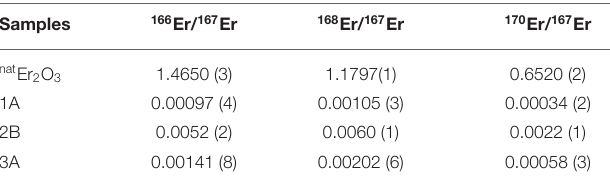
TABLE 4 | Comparison of the ICP-MS results of the natural and mass 167 separated samples (1A, 2B, and 3A).